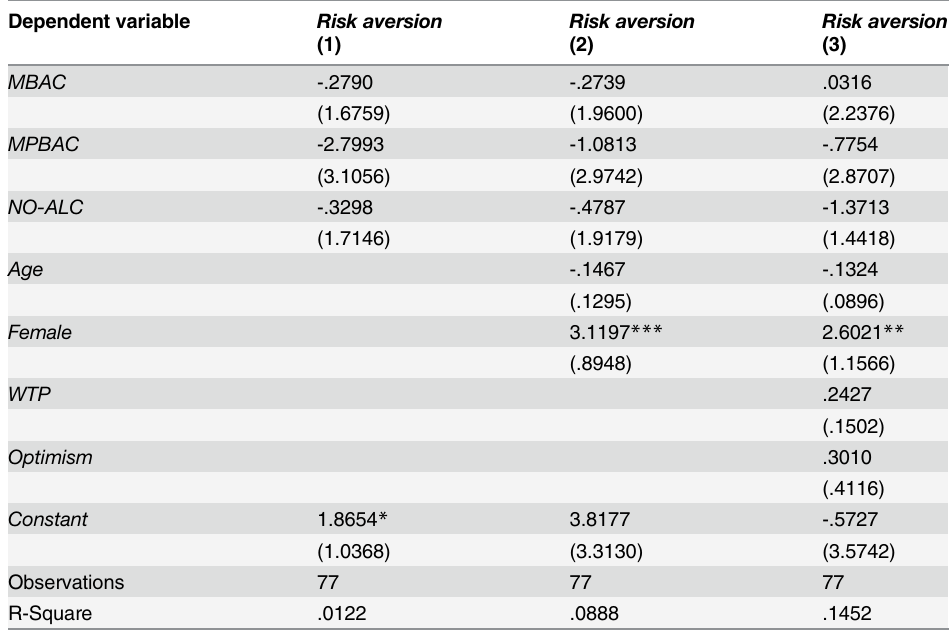
Table 4. Alcohol and Risk